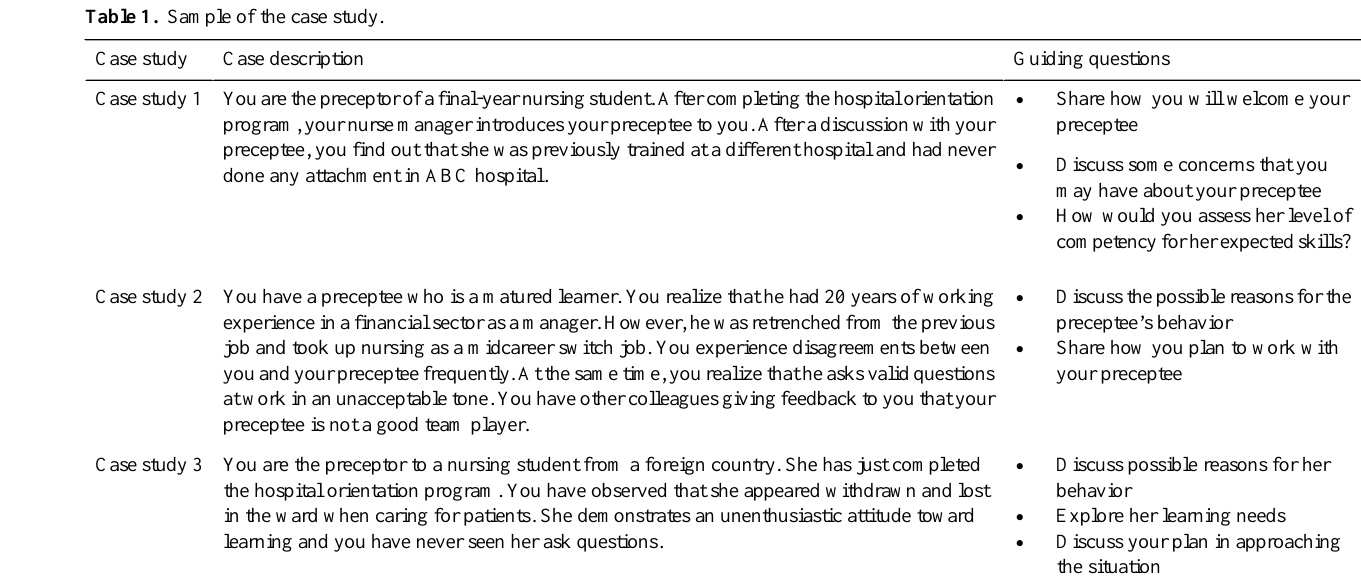
Table 1. Sample of the case